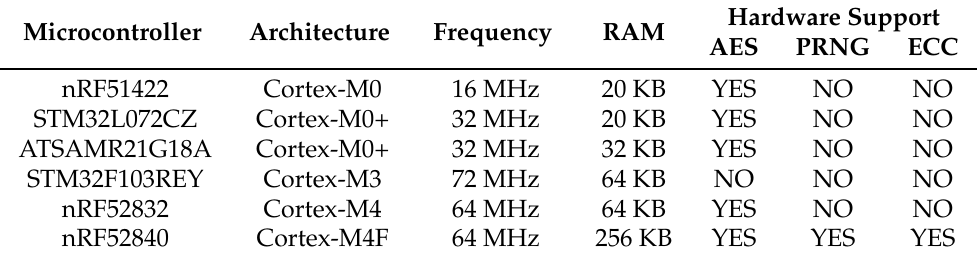
Table 7. Overview of microcontroller specifications used in the experimental